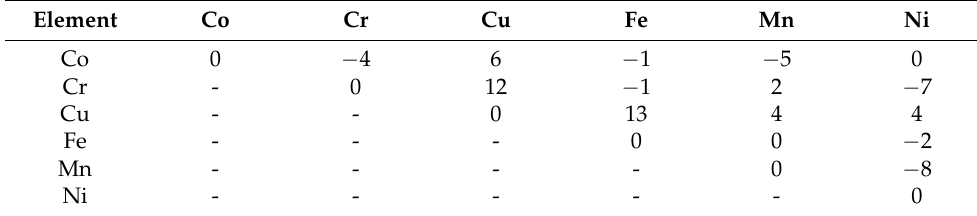
Table 3. Mixing enthalpy of binary liquid alloy of the CoCrCuFeMnNi HEA system (KJ/mol) [42].